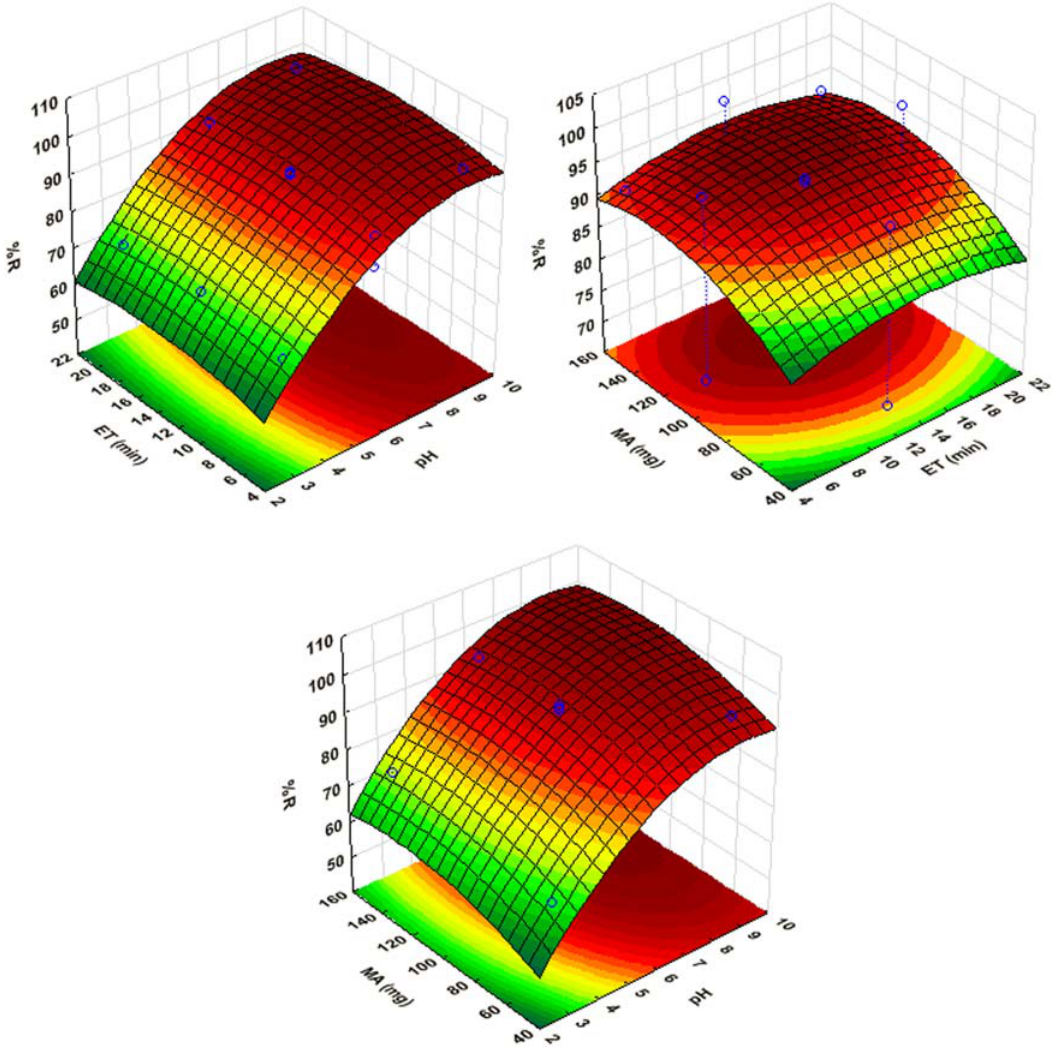
Figure 8: Three - dimensional response surface plots for the preconcentration of Tl as a function of experimental